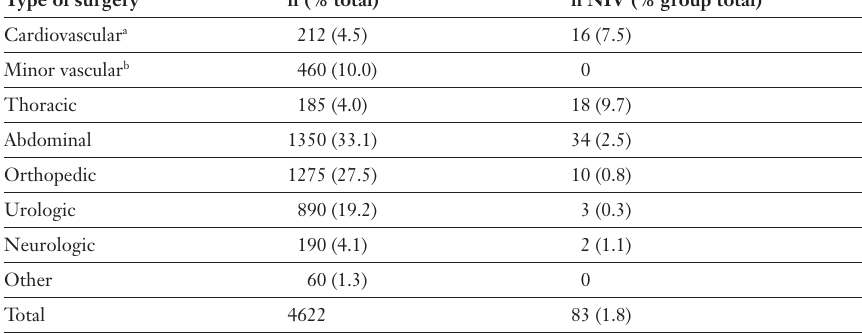
Type of surgical pro- cedure and incidence of non-invasive venti- lation